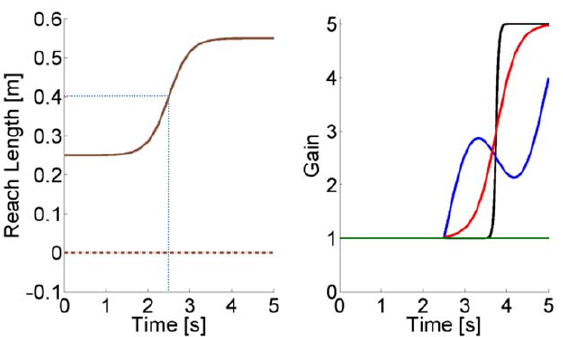
Figure 3. Representation of the imposed reaching trajectory and the multipliers for the stiffness time profiles. In the left panel, the reaching profile for the x (solid) and y (dashed dotted) components of movement are represented using the convention of Figure 1. The co-ordinates shown in light blue refer to the position of the hand’s center of mass used in the static (postural) condition. For the first part of the trajectory, a constant stiffness and damping are imposed at the beginning of the movement (right panel). Subsequent- ly, after the application of a force impulse perturbation, the joint stiffness is modulated by means of the gain profiles depicted on the right panel. We imposed a constant (green), slow sigmoidal (red), a combination of linear and sinusoidal (blue), and sharp sigmoidal gain (black), respectively. The same time-varying profiles are also imposed to stiffness and damping during the simulated static condition.